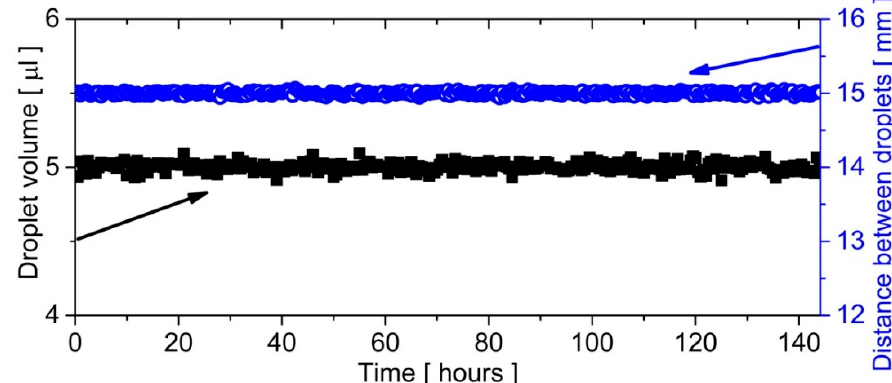
Figure 3. The time evolution of the droplet volume and the distance between droplets circulating in the microfluidic closed loop. For both parameters, the size of the point corresponded to the standard deviation, which was calculated from a sample containing ten droplets flowing in a loop. Since no changes of volume or distance were observed, one can conclude that the motion of droplets in the microfluidic loop was stable even on large time scales.